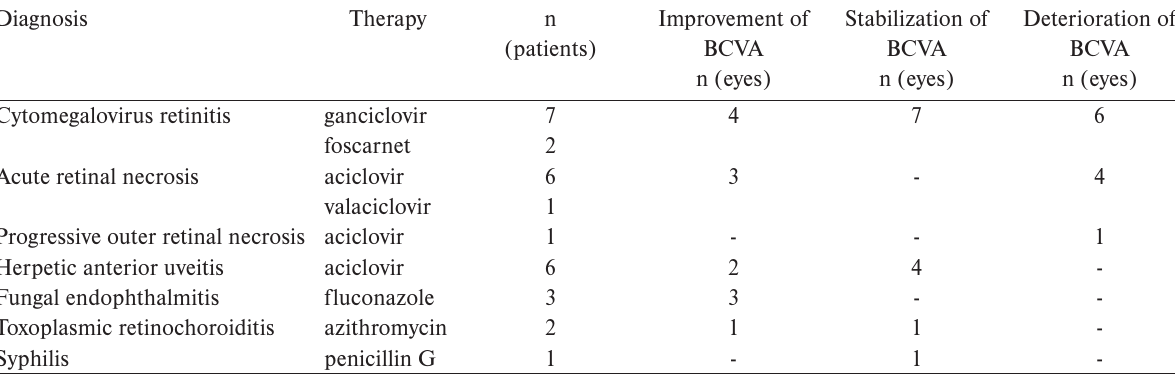
Table 3. Results of BCVA in immunocompromised patients treated with anti-infectious